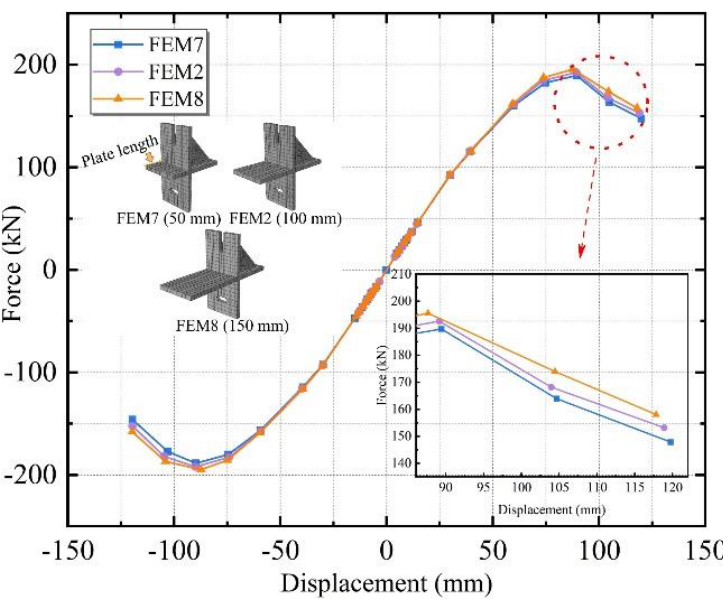
Figure 19. Skeleton curves of specimens with different plate lengths.